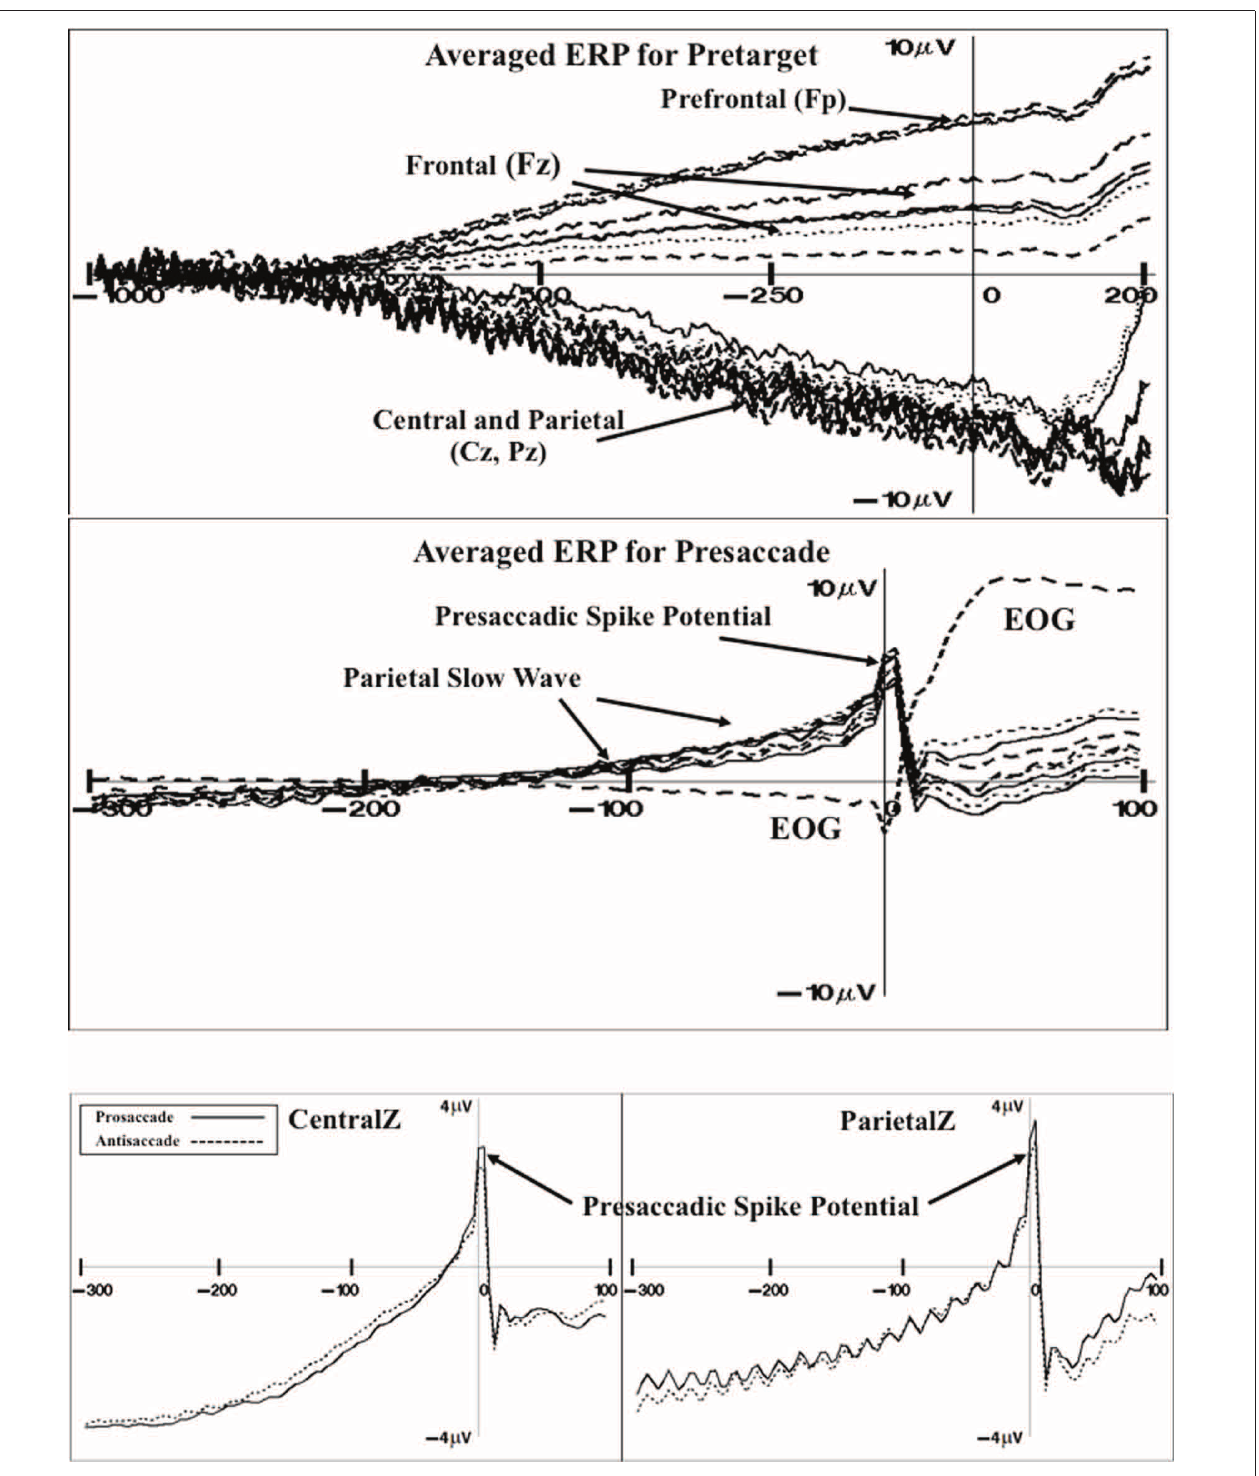
FIGURE 4 | Grand average ERP for pretarget activity for representative electrodes (top panel). The pretarget period shows frontal pole (Fp) and frontal (Fz) electrodes showing a slow positive ERP component simultaneous with central (Cz) and parietal (Pz) electrodes showing a slow negative ERP component (CNV). Grand average ERP for presaccade activity for